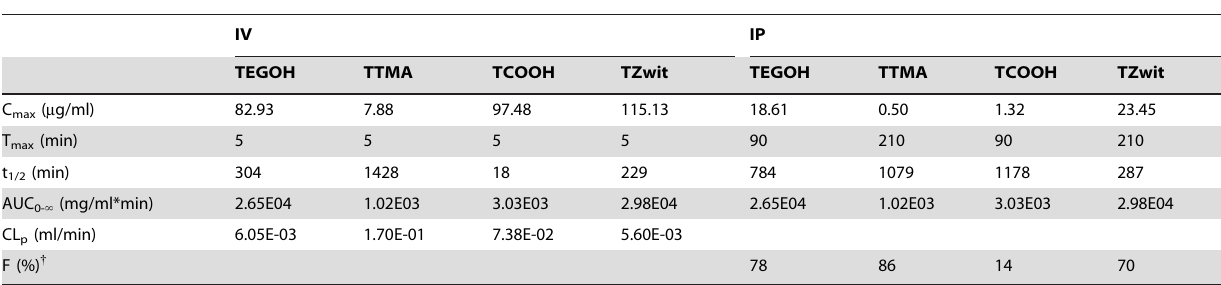
Table 1. AuNP Pharmacokinetics Summary.